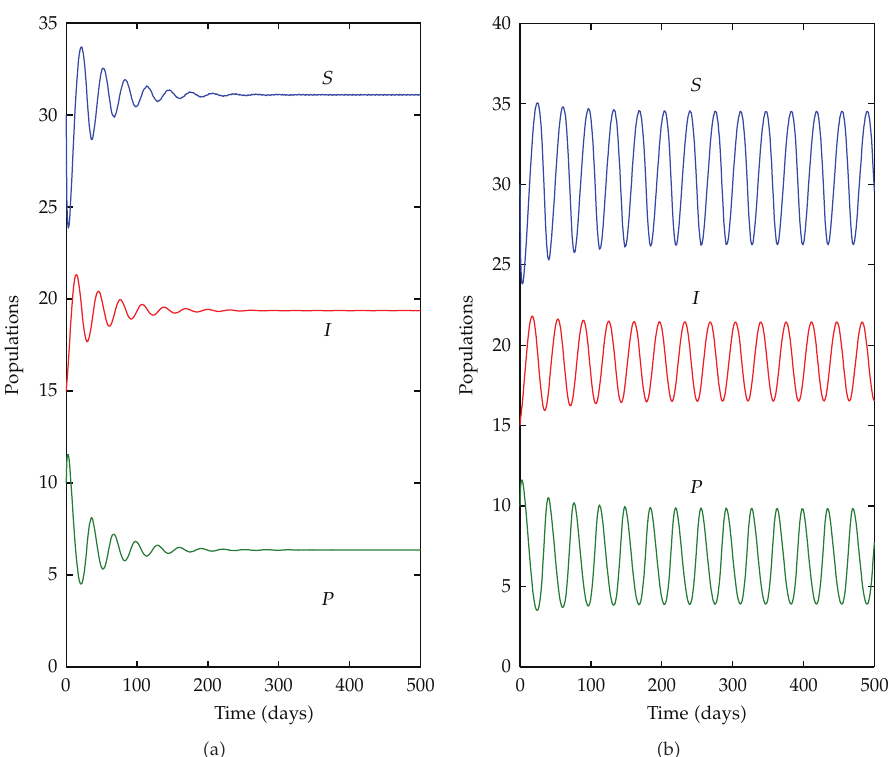
Figure 3: Behavior of the system (cid:7) 1.2 (cid:8) for di ff erent τ : (cid:7) a (cid:8) τ (cid:5) 1, (cid:7) b (cid:8) τ (cid:5) 3. All parameters are as in Figure 2 except m (cid:5) 0 . 72. This figure represents the conditional stability of the coexisting equilibrium E ∗